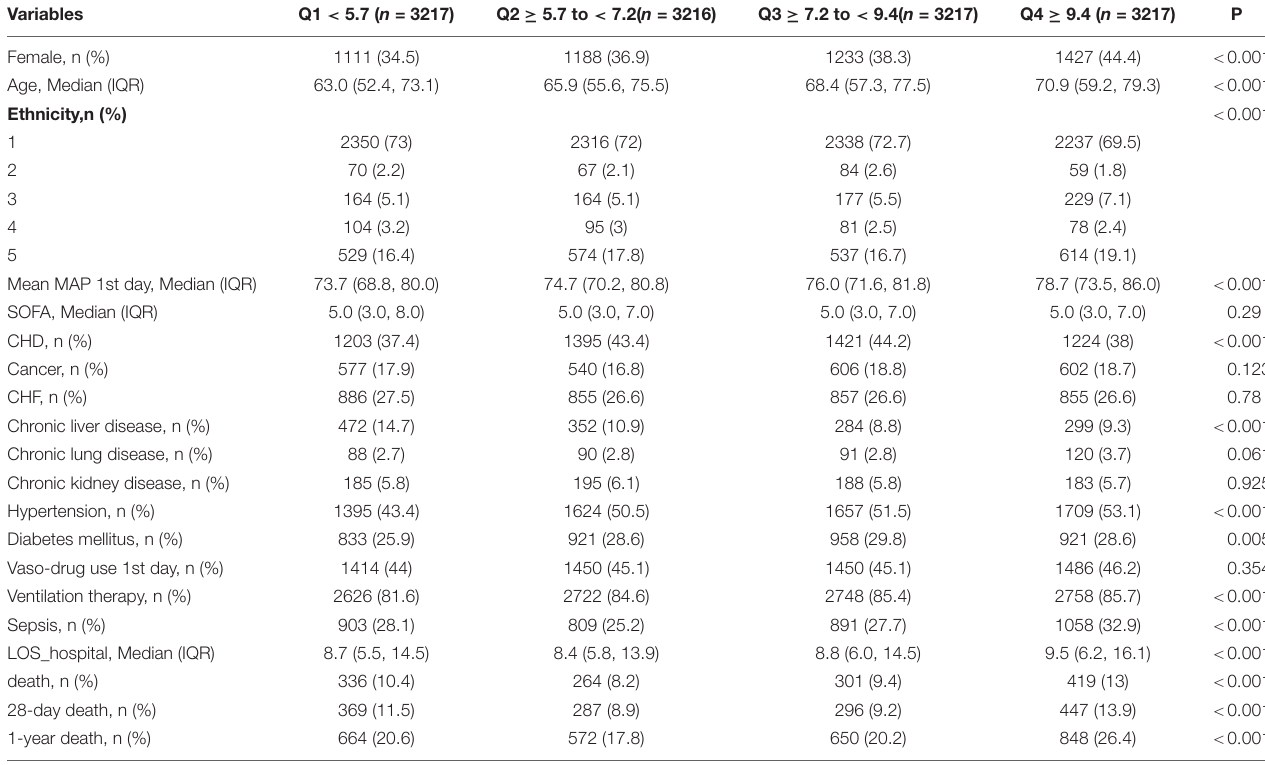
TABLE 1 | Characteristics of the study population grouped by the quartiles of MAP ARV.